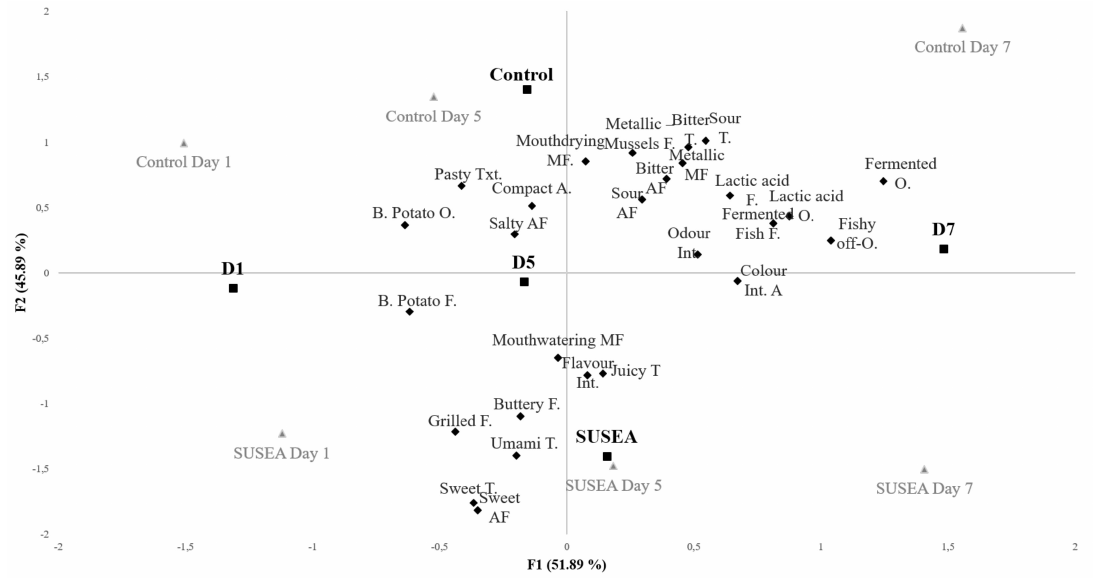
Figure 3. Principal Component Analysis (PCA) bi-plot of descriptive analyses (DA) data after Varimax rotation, including as observations the study design factors ( (cid:4) ) and as variables ( (cid:7) ), descriptors with a p < 0.1 according to the factorial study. Study design factors, Treatment (Control (untreated) and SUSEA (treated) gilthead seabream fillets) and storage Day (D1, D5 and D7). DA samples are included as supplementary observations ( (cid:78) ). Total explained variance of factor 1, F1 and F2: 97.97%. O, A, T, F, Txt, AF and M stand for odor, appearance, taste, flavor, texture, aftertaste and mouthfeel,